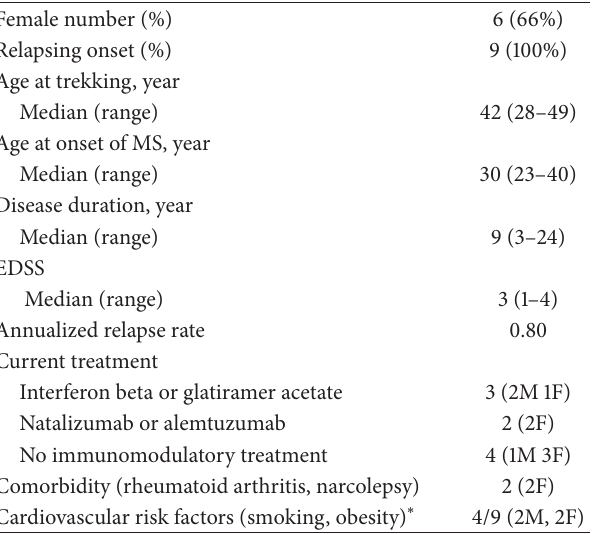
Table 2: Baseline characteristics of the participants ( 𝑛 = 9